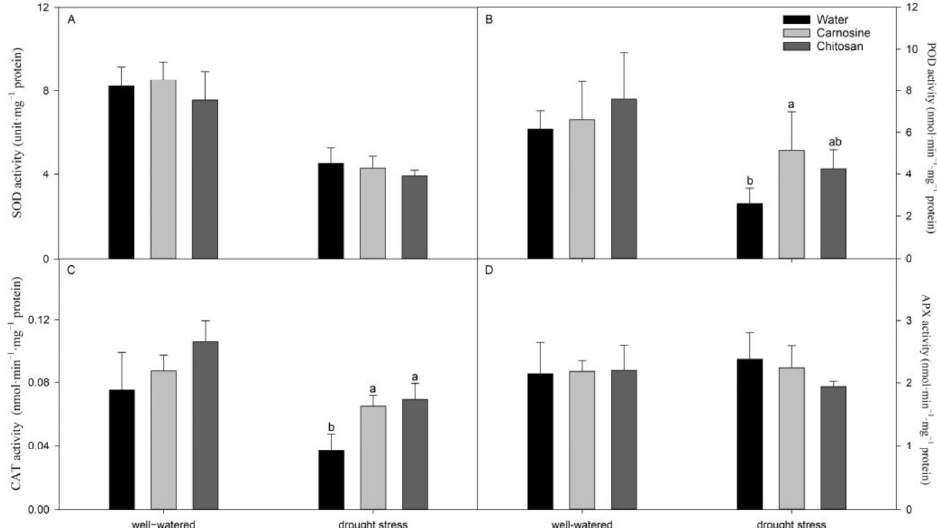
Figure 8. Effects of carnosine and chitosan on the activities of SOD ( A ), POD ( B ), CAT ( C ), and APX ( D ) in bermudagrass. ‘Water’ represents control plants sprayed with distilled water under both well-watered and drought stress. The columns represent the means and standard errors (SE) of 5 replicates. The different letters represent a significant difference among treatments at the same time point at p < 0.05.